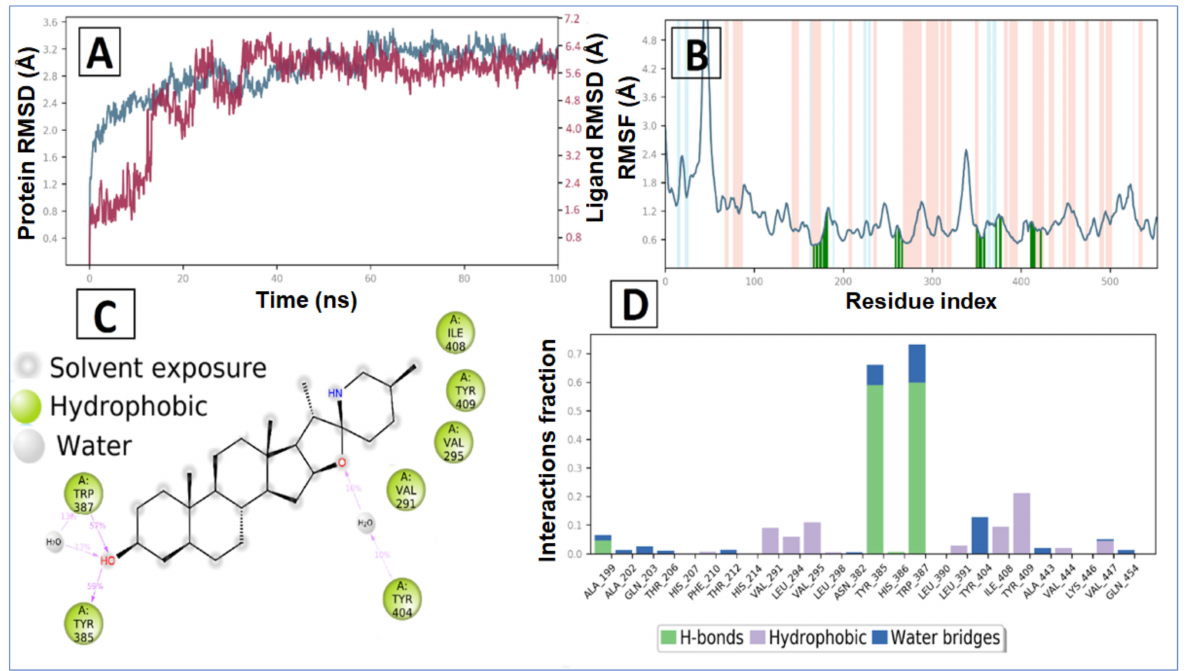
Figure 8. MD simulation analysis of tomatidine -human COX-2 complex: ( A ) RMSD (protein RMSD is shown in grey while RMSD of tomatidine are shown in red), ( B ) Protein RMSF, ( C ) 2D interaction diagram and ( D ) protein–ligand contact analysis of MD